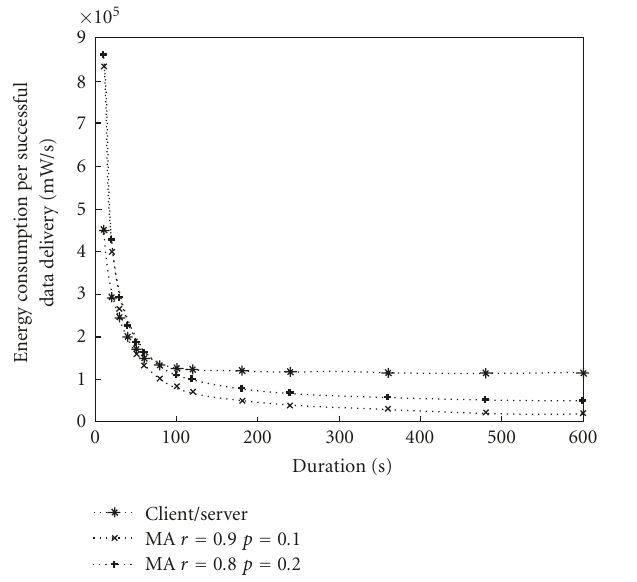
Figure 11: The impact of τ on T ete .